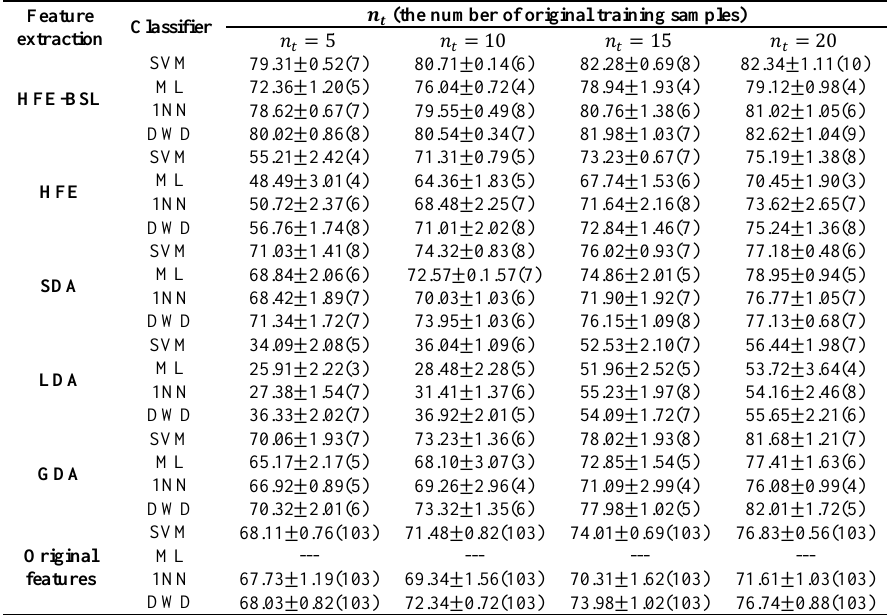
Table 8. Highest average classification accuracies and their corresponding standard deviations for Pavia dataset. Number in parenthesis represents number of features achieving highest accuracies in experiments.